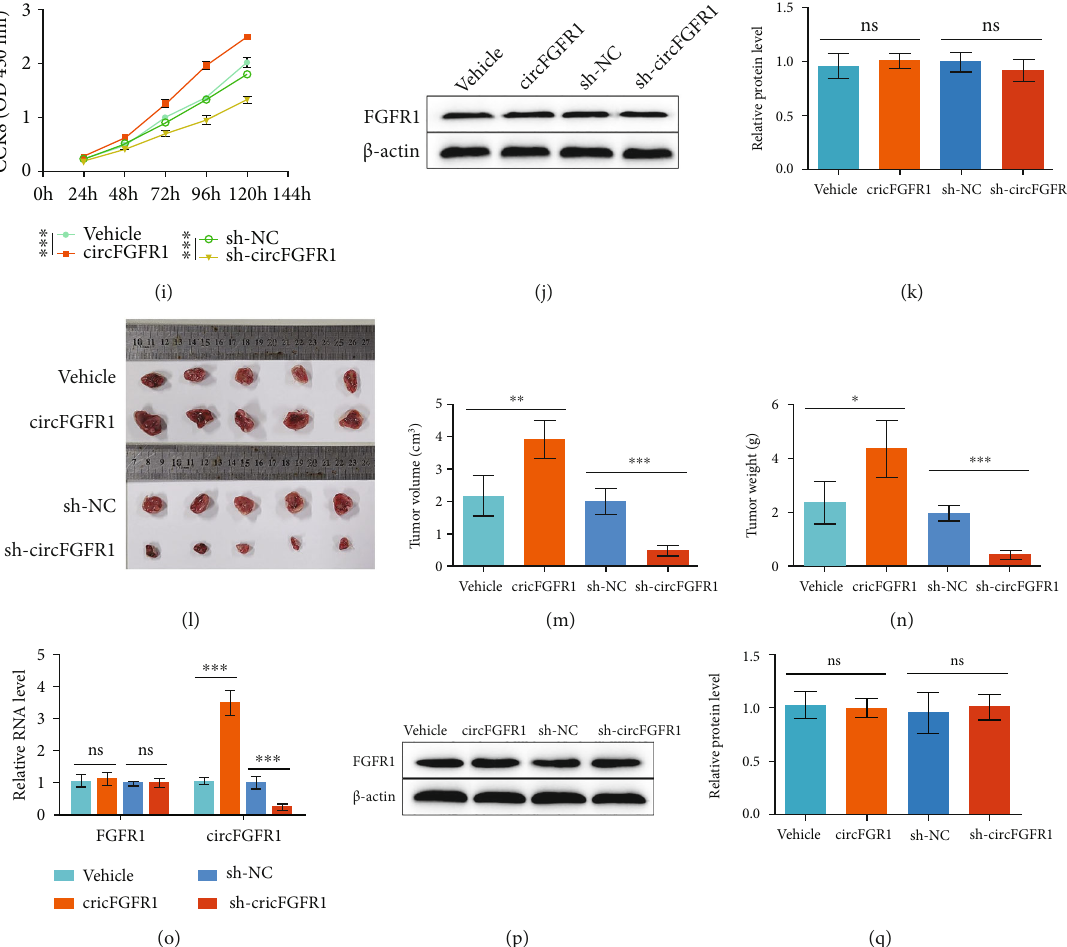
Figure 1: Upregulation of circFGFR1 promotes the glioma development. (a) The clinical data of FGFR1 expression in the normal persons and GBM patients from GEPIA database. (b) The heat map of circRNA expression in di ff erent cell lines analyzed by qPCR. Data are processed with Log2. (c) The expression pro fi le of circFGFR1 in di ff erent cell lines from (b). (d – k) SNB19 cells overexpressing Vehicle, circFGFR1, sh-NC, and sh-circFGFR1, respectively, by transducing lentivirus and screening with puromycin. (d) The expression of FGFR mRNA and circFGFR1 in those engineered SNB19 stable cell lines analyzed by qPCR. (e, f) The migration ability of those engineered SNB19 stable cell lines analyzed by Matrigel-free Transwell assay. (g, h) The invasion ability of those engineered SNB19 stable cell lines analyzed by Matrigel-based Transwell assay. (i) The proliferation ability of engineered SNB19 cell lines analyzed by CCK8 assay. (j, k) The expression of FGFR1 protein in engineered SNB19 cell lines analyzed by western blot. (l – q) The xenograft tumors generated by injecting SNB19 cells stable overexpressing Vehicle, circFGFR1, sh-NC, and sh-circFGFR1 into nude mice, respectively. (l) The images of xenograft tumor in di ff erent groups. (m, n) The tumor volume and weight at 30 days after cell injection. (o) The expression of FGFR1 mRNA and circFGFR1 in xenograft tumors analyzed by qPCR. (p, q) The expression of FGFR1 protein in xenograft tumors analyzed by western blot. The data are presented as the means ± SD , n = 3 experiments in (b – k), n = 6 experiments in (l – q), ∗ p < 0 : 05 , ∗∗ p < 0 : 01 , ∗∗∗ p < 0 : 005